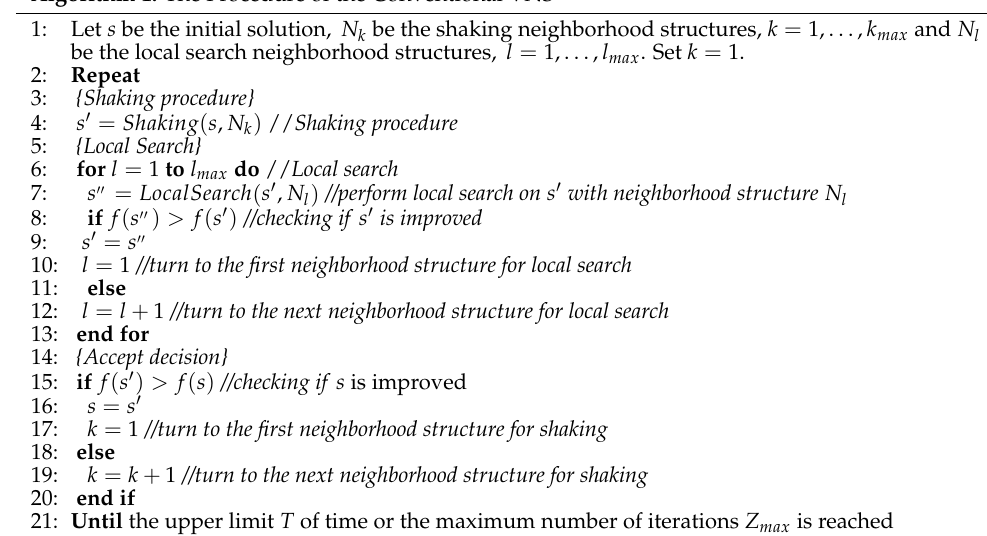
Algorithm 1. The Procedure of the Conventional